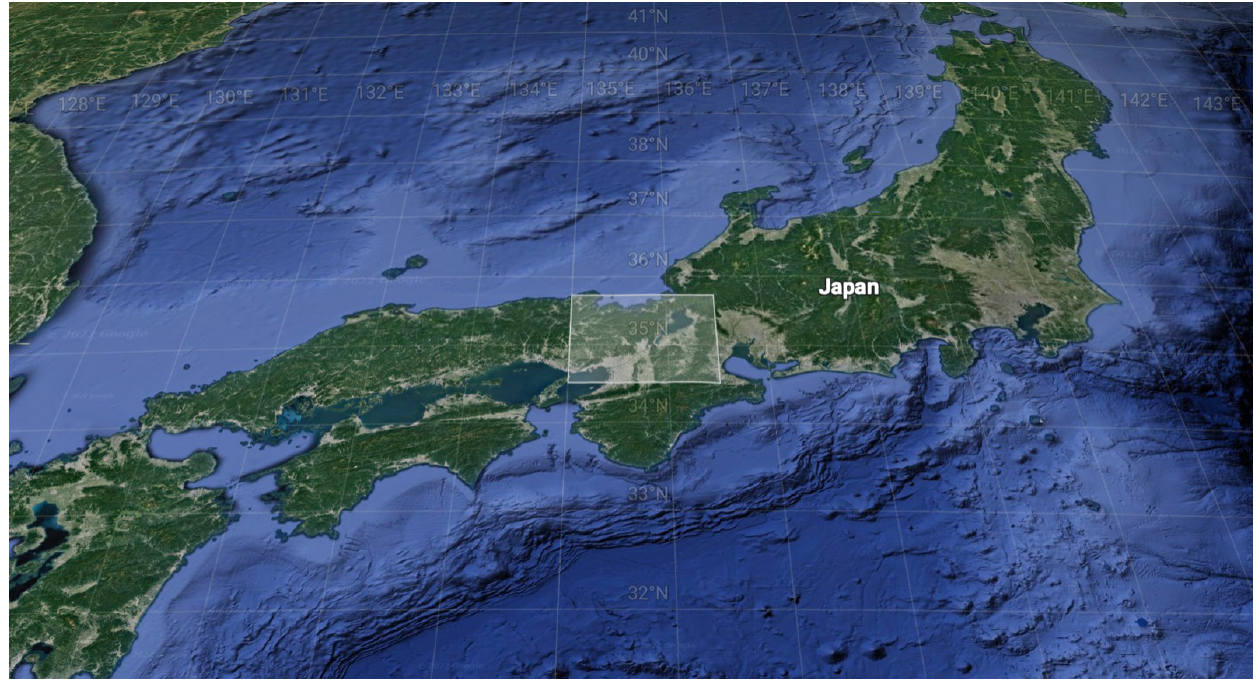
Figure 1. The map of Japan in which is highlighted the area that represents the domain covered by the weather radar whose data are used in this